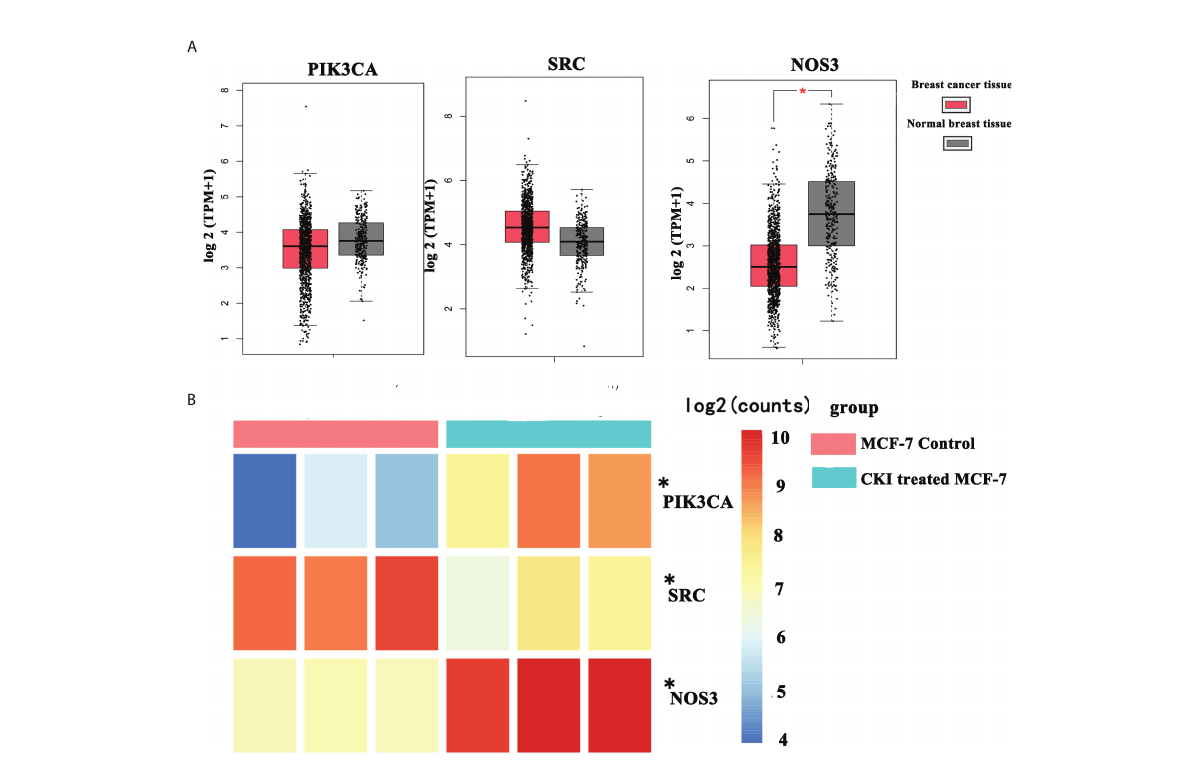
FIGURE 7 The mRNA expression of PIK3CA, SRC and NOS3 in breast cancer from TCGA data and chip GSE78512. Notes: (A) The mRNA expression of PIK3CA, SRC and NOS3 in breast cancer from TCGA data. (B) The mRNA expression of PIK3CA, SRC and NOS3 in breast cancer from chip